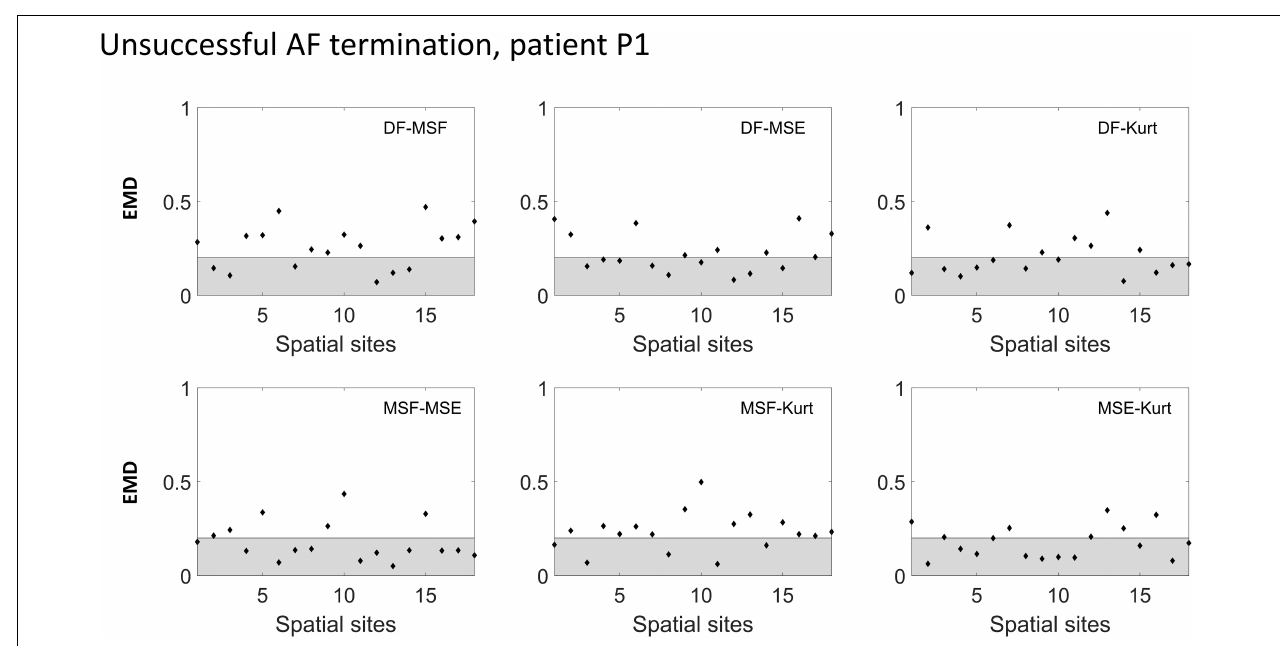
FIGURE 3 | The 3D visualization of the individual approaches (DF, MSF, MSE, and Kt) generated using VIEgram software for a specific successful AF termination patient P8. Sample of BiEGM recorded from LSPV (#) is shown along with individual DF, MSF, MSE, and Kt values.